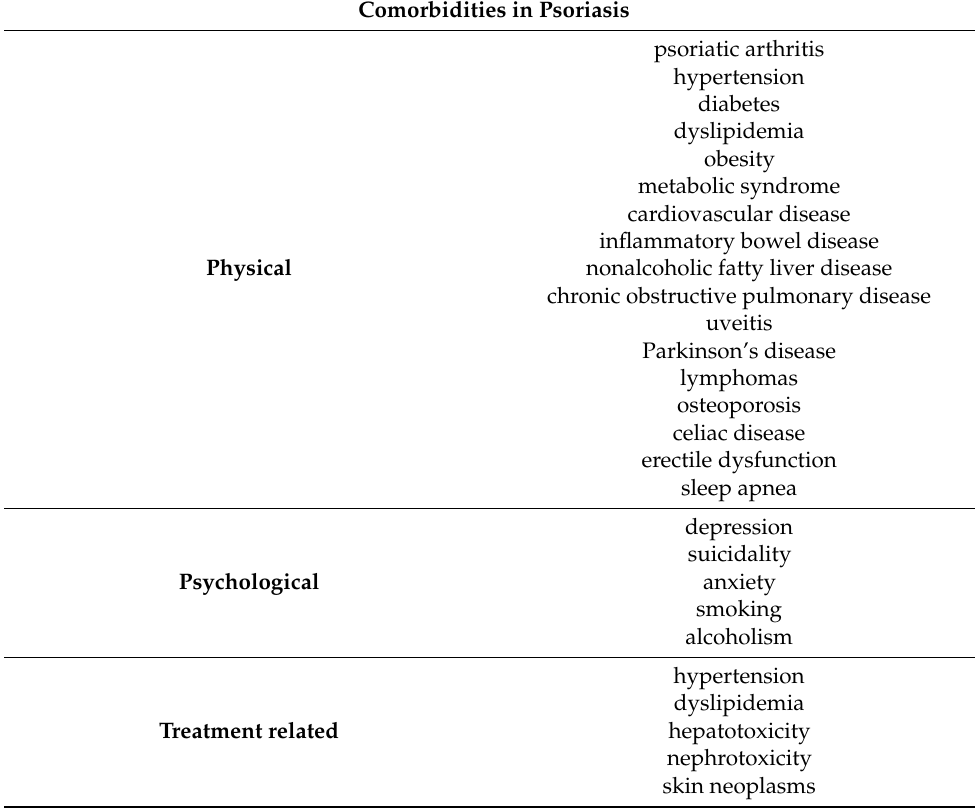
Table 1. Comorbid diseases in